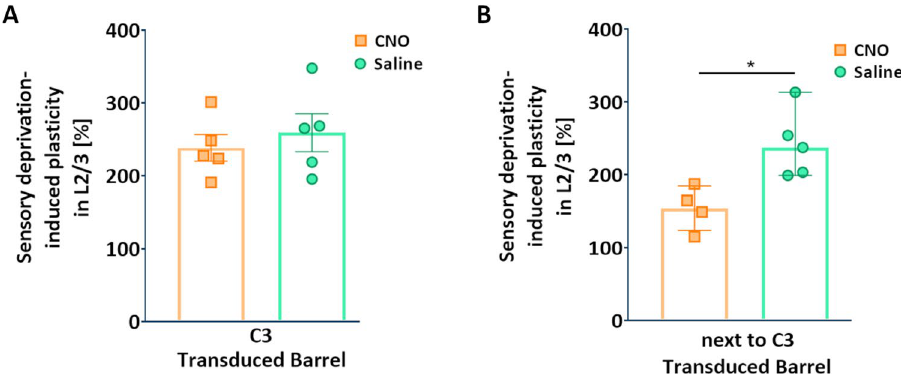
Figure 4. The effect of chemogenetic SOM-IN inhibition on deprivation-induced plasticity in supragranular layers of the barrel cortex. ( A ) Scatter plots presenting the percentage normalized values (mean ± SEM) of the change of sensory deprivation-induced increase in area activated by C3 whisker (analyzed in layer 2/3) between hemispheres (described as the plasticity, Y-axis) in two groups of animals (X-axis) with SOM-INs transduced with inhibitory DREADDs in “C3” barrel and receiving CNO or saline. ( B ) Scatter plots presenting the percentage normalized values (median ± range) of the change of sensory deprivation-induced increase in C3 labeling (analyzed in layer 2/3) between hemispheres (described as the plasticity, Y-axis) in two groups of animals (X-axis) with SOM-INs transduced with inhibitory DREADDs in “next to C3” barrel and